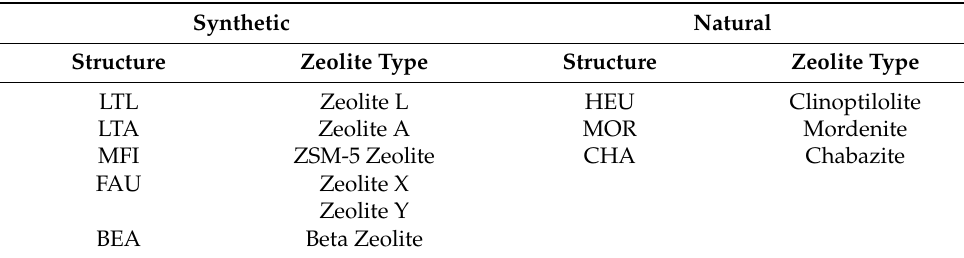
Table 1. Some types of zeolites.